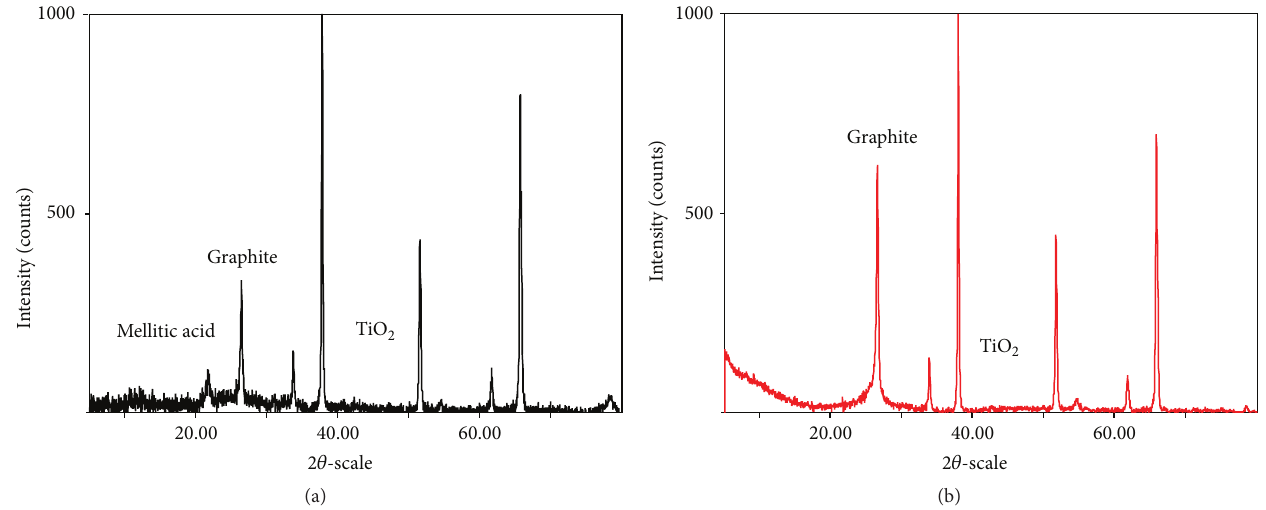
Figure 2: The X-ray diffraction pattern of (a) preheated and (b) sintered HC